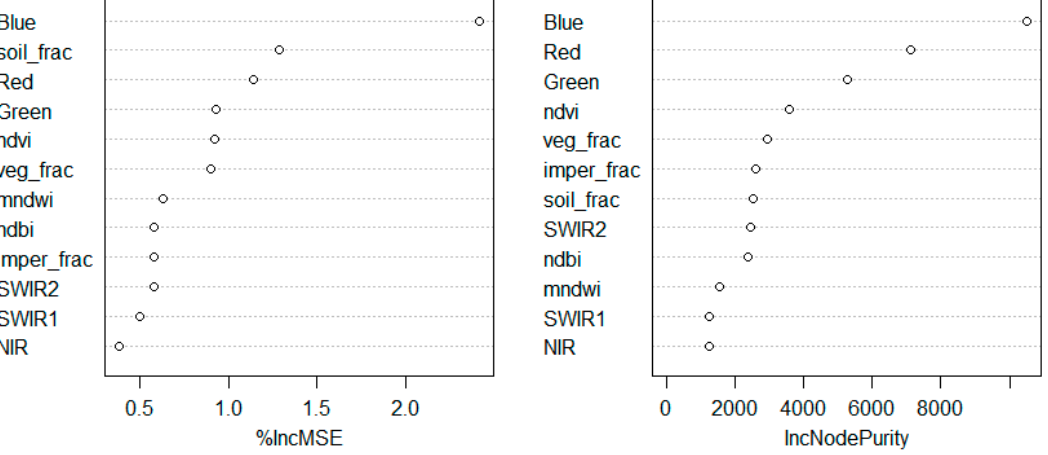
Figure 11 . RF importance ranking of independent variables for region B; imper_frac, veg_frac, and soil_frac stand for impervious surface, vegetation, and soil fractions, respectively. MNDWI is the modified normalized difference water index, NDBI is the normalized difference built-up index, and NDVI is the normalized difference vegetation index.